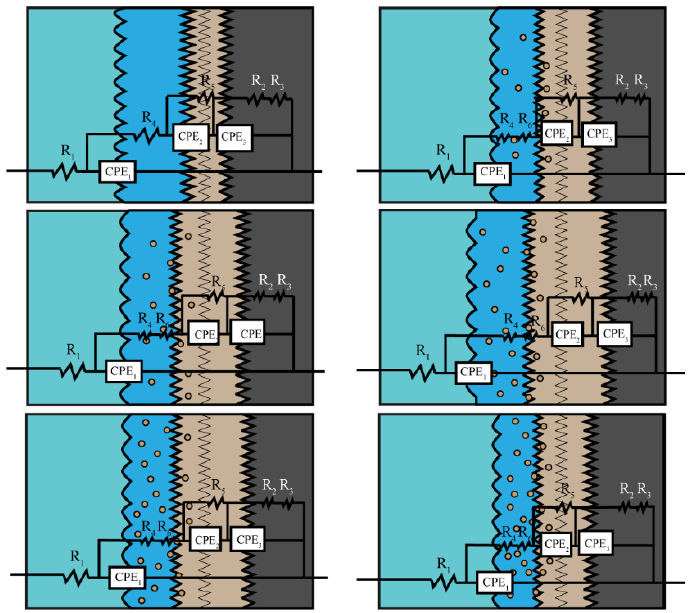
Figure 12. Equivalent circuit diagram of coatings with different particle concentrations prepared on 45 steel substrates through scanning electrodeposition. Table 6. Equivalent circuit diagram parameters of coatings with different particle concentrations prepared on 45 steel substrates through scanning electrodeposition.